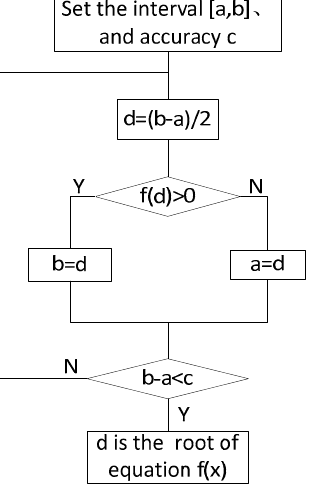
Figure 11. Flow chart of the dichotomy.